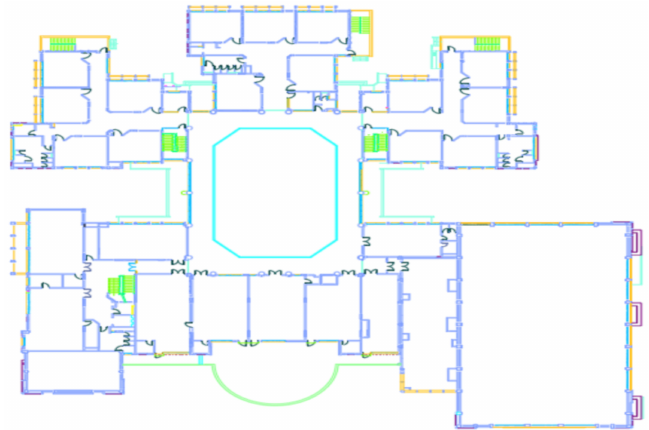
Figure A3. Air handling units in ground floor.